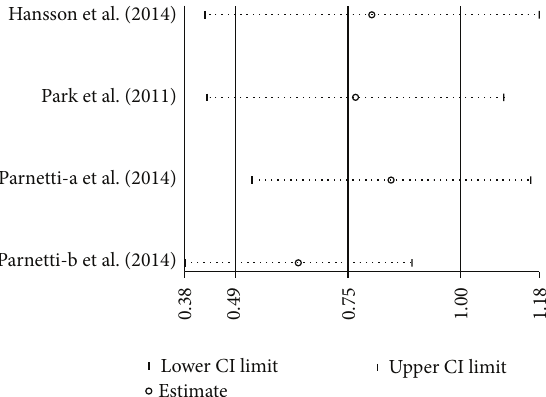
Figure 12: Sensitivity analysis of CSF 𝛼 -syn oligomers levels in PD compared to control.